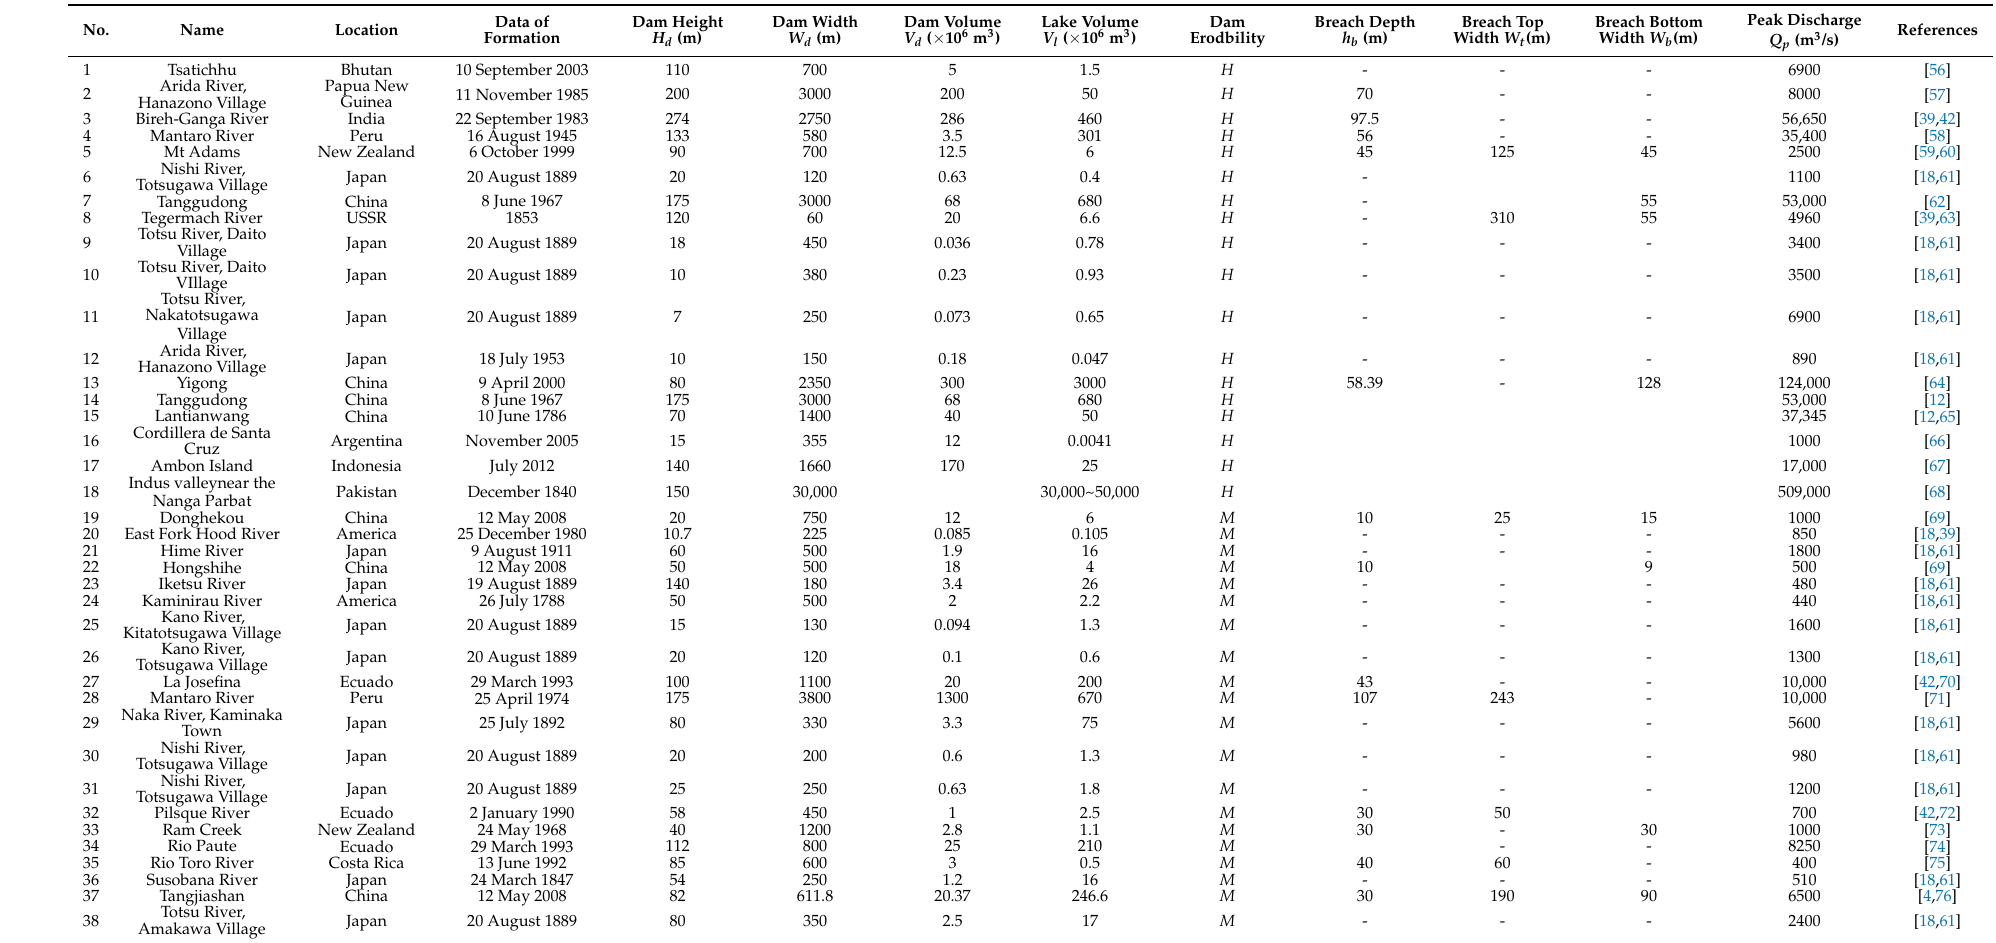
Table A1. Historical case data of landslide dam failure. “ H ” refers to the high erodibility of the landslide dam, “ M ” refers to the moderate erodibility of the landslide dam, “ L ” refers to the low erodibility of the landslide